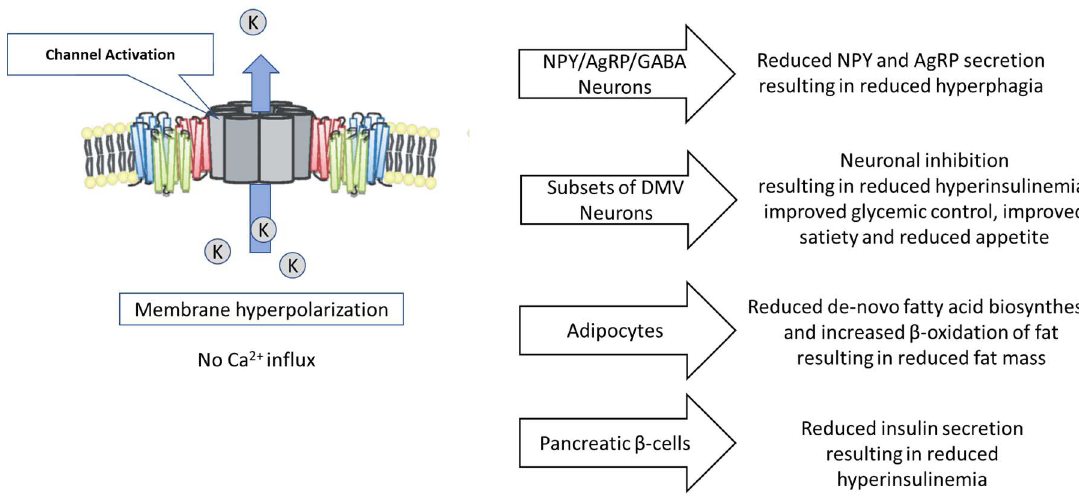
Figure 1. The Potential Role of the K ATP Channel in the Regulation of Cellular and Physiological Processes Associated with Establishing and Maintaining the Obese Hyperphagic State.